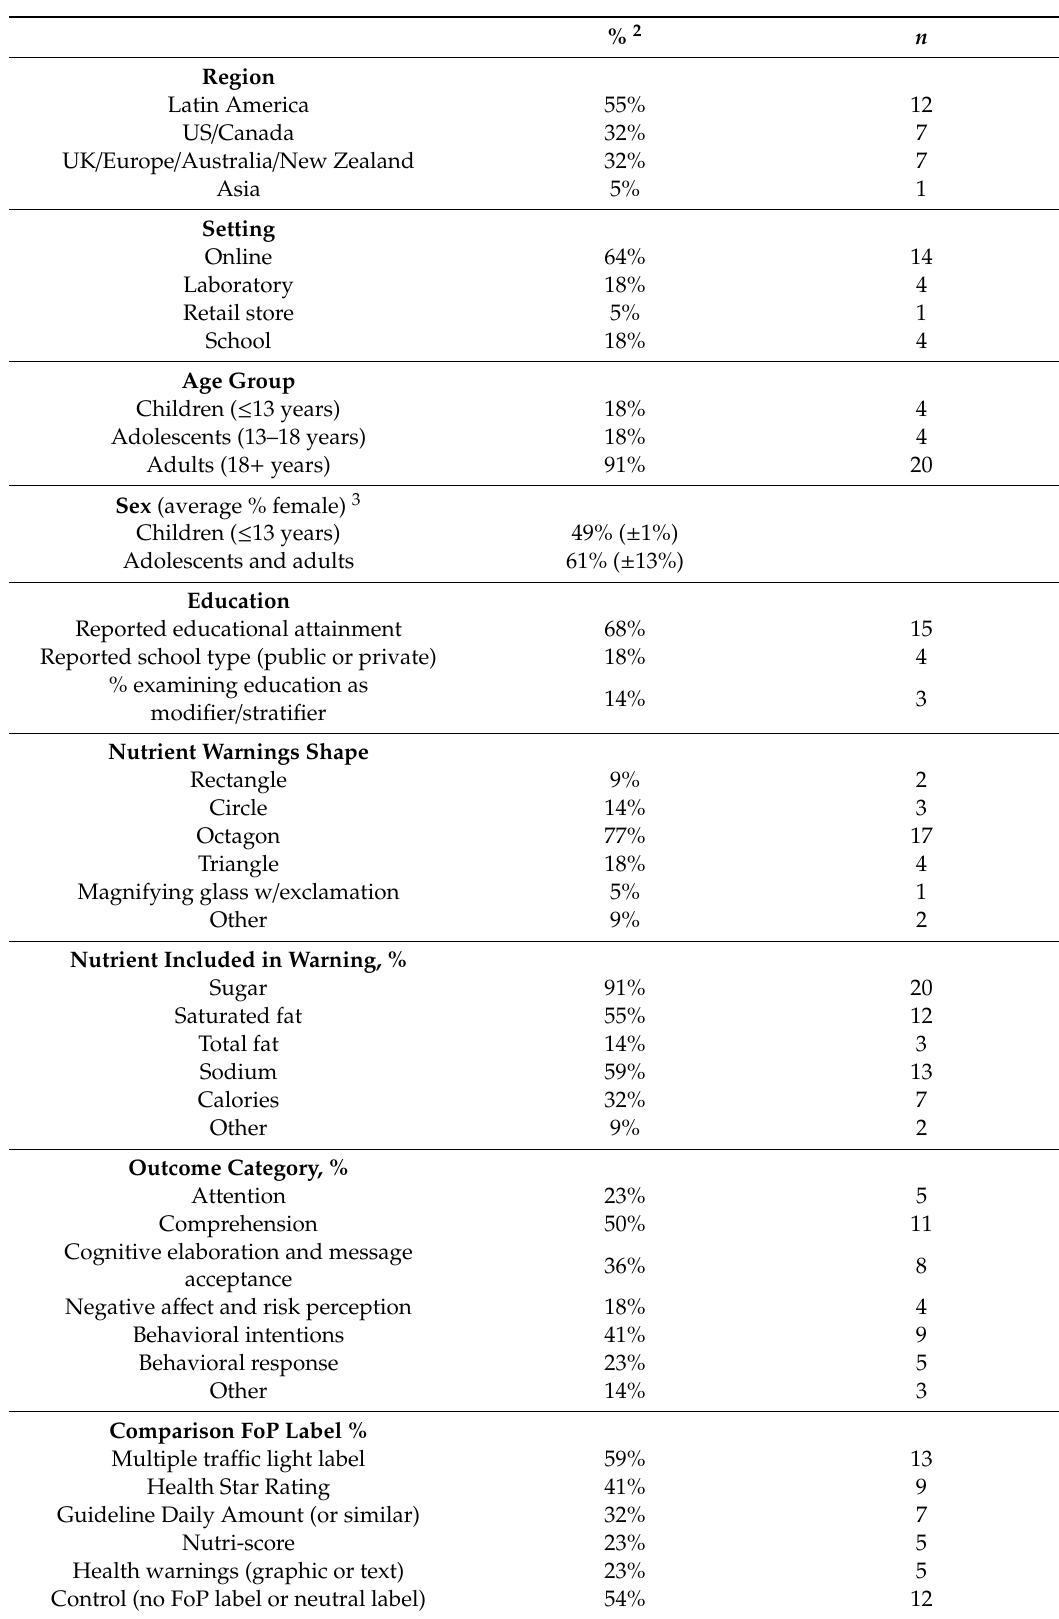
Table 1. Study characteristics 1